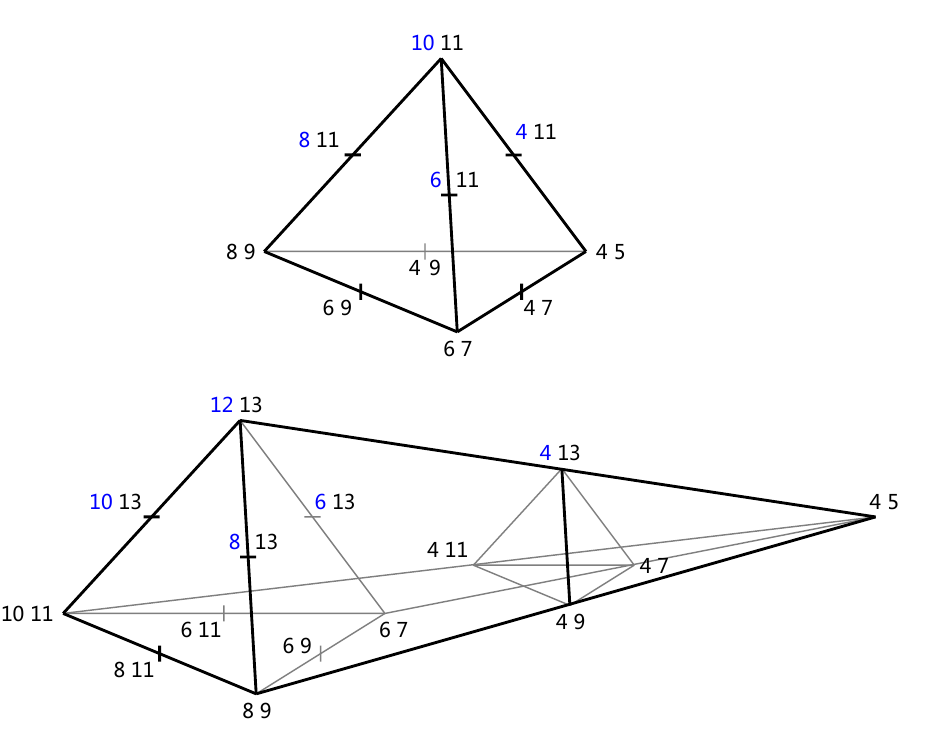
Figure 18 . Solid 3- and 4-simplices of level 2 with growing parameters (10 ; 8 ; 6 ; 4) and (12 ; 10 ; 8 ; 6 ; 4)